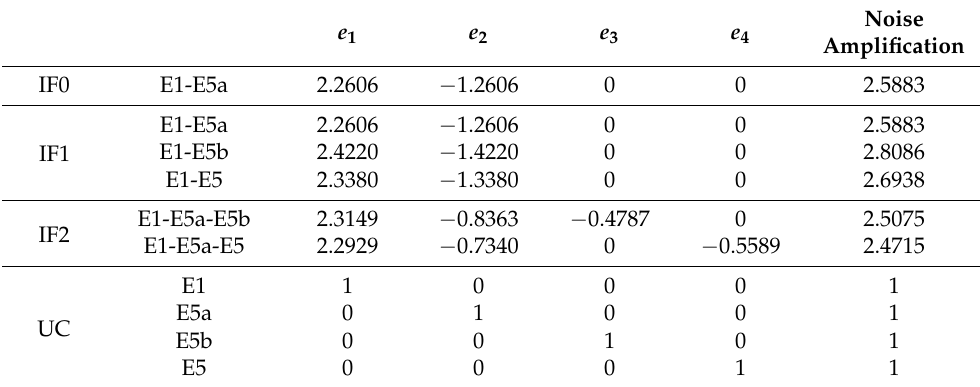
Table 2. Comparison of dual- and four- frequency Galileo PPP time transfer